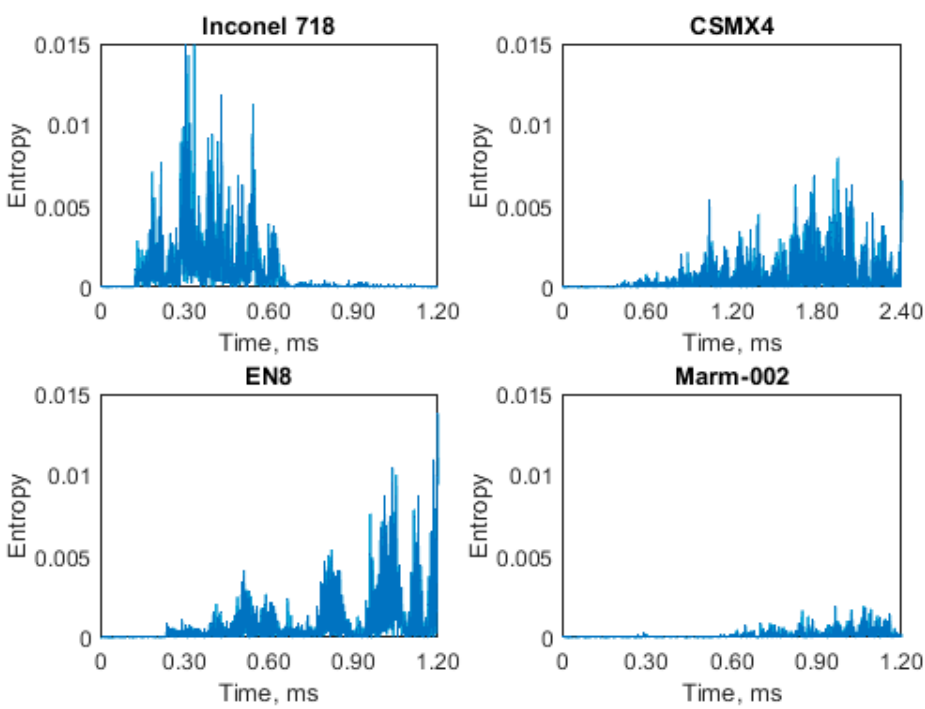
Figure 23. Shannon entropy of the SG tests for Inconel 718, CSMX4, EN8, and MARM-002.